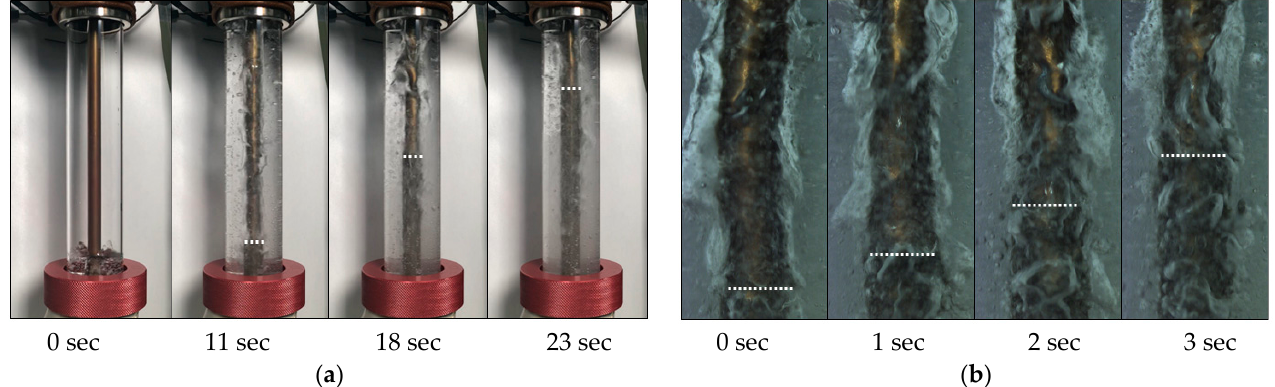
Figure 7. Pictures of the CrAl-coated Zr cladding quenching at Tw = 800 °C, T sub = 5 °C and Vc = 0.05 m/s using; ( a ) digital camera; ( b ) high-speed camera.